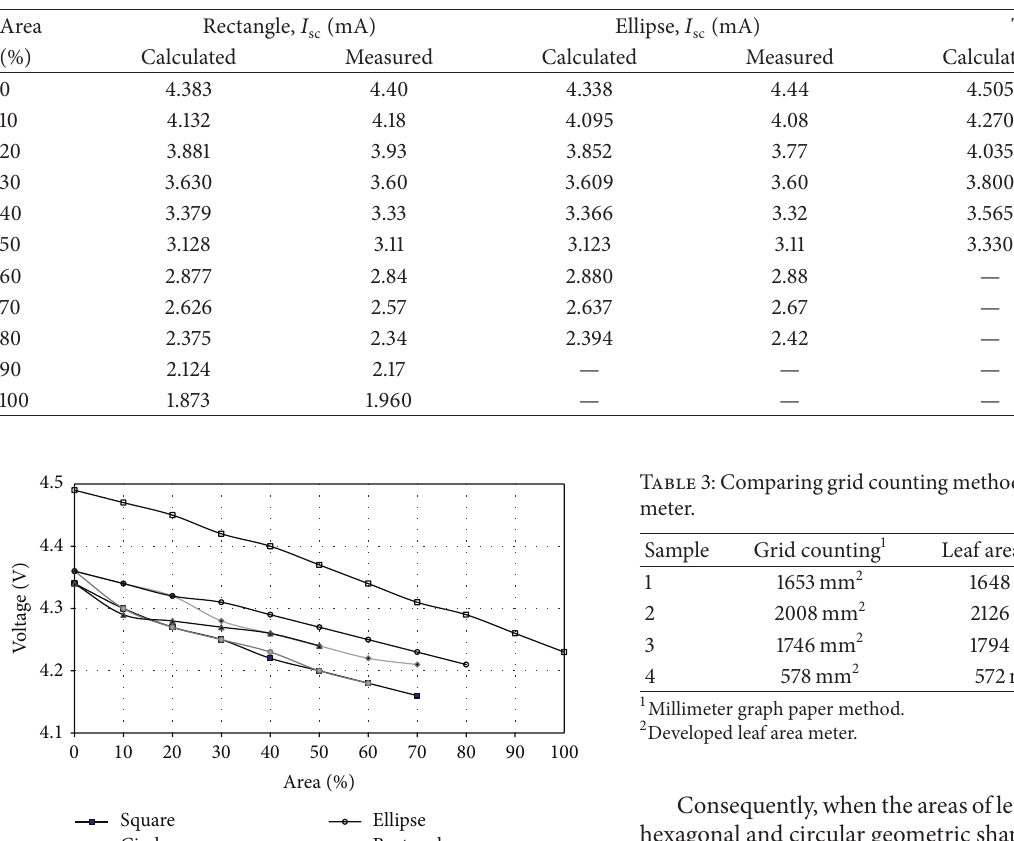
Table 1: Measured and obtained values for rectangle, ellipse, and triangle shaped areas indicating the relation between area and short circuit current of solar module.